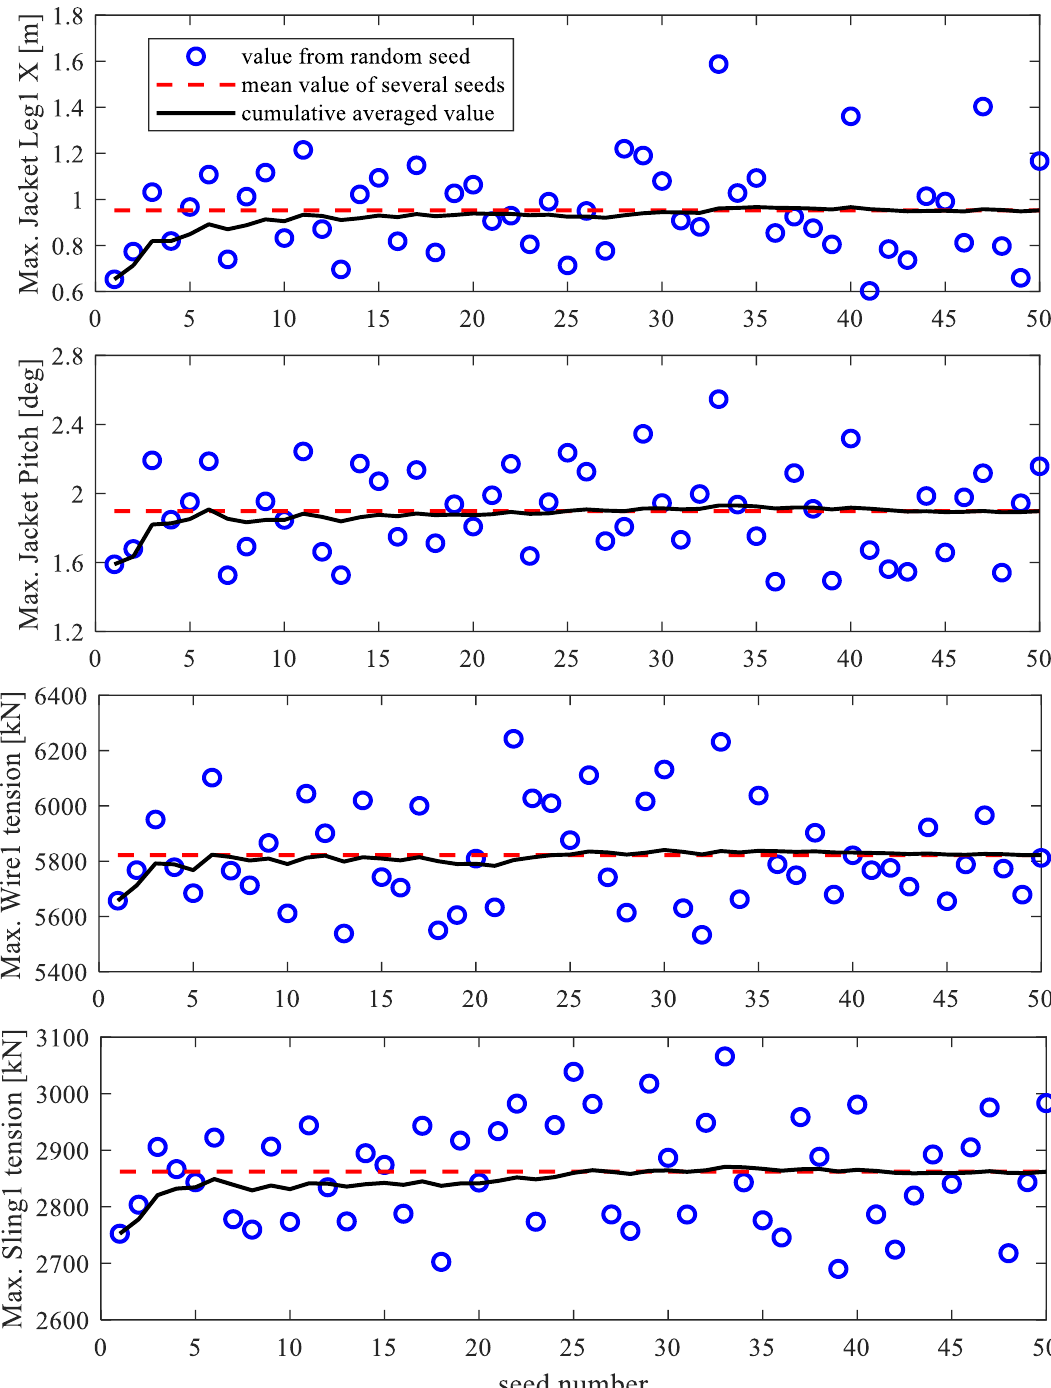
Figure 11. Convergence test results. ( H s = 1.5 m, T p = 7 s, Dir = 45 deg, JL1-Z3). The extreme responses of three preliminary positions are compared in Table 6. The motion of the jacket is relative to the equilibrium position. Because static tension and dynamic tension are different in different positions, and it is necessary to compare the DAF (the ratio of maximum tension to static tension). As can be seen from Table 6, JL1-Z3 is the most dangerous position with the largest dynamic response; therefore, JL1-Z3 was selected as the most critical position for subsequent